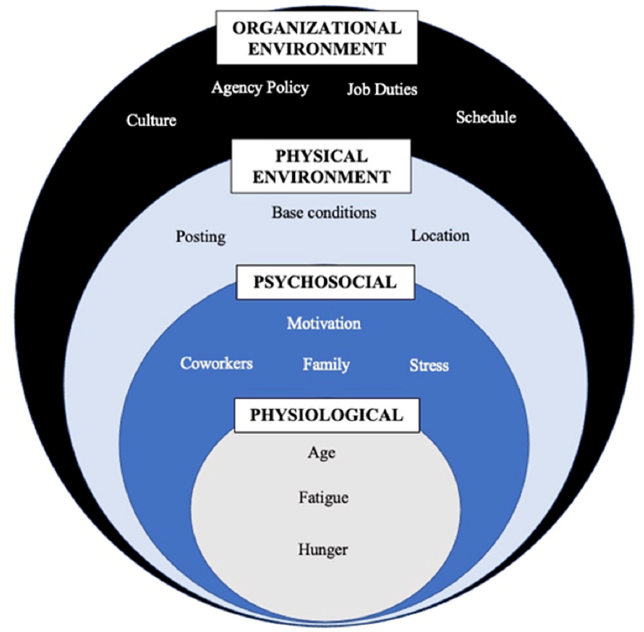
Figure 1. Conceptual model —From the major themes, we developed the following conceptual model informed by the social ecological model. The model displays the four overarching, interrelated themes, each containing commonly discussed factors describing the context in which food choice and eating occur for EMS providers. Table 1. Participant